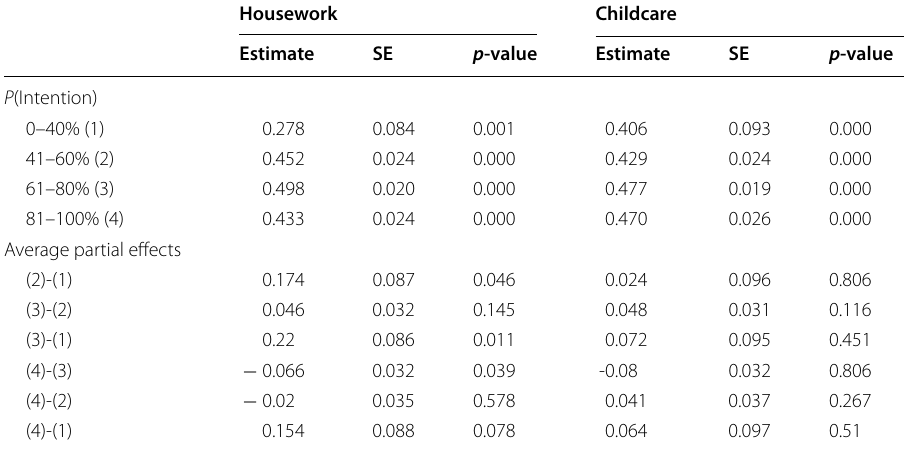
Table 4 Predicted probabilities and average partial effects of the distribution of housework and childcare Housework Childcare